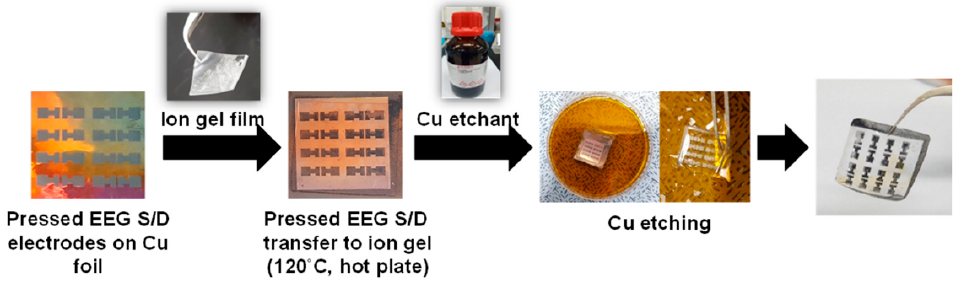
Figure 5. Photo images of the manufacturing process of the hot-pressed EEG S/D electrodes via transferring to the ion gel dielectric layer and Cu foil etching.